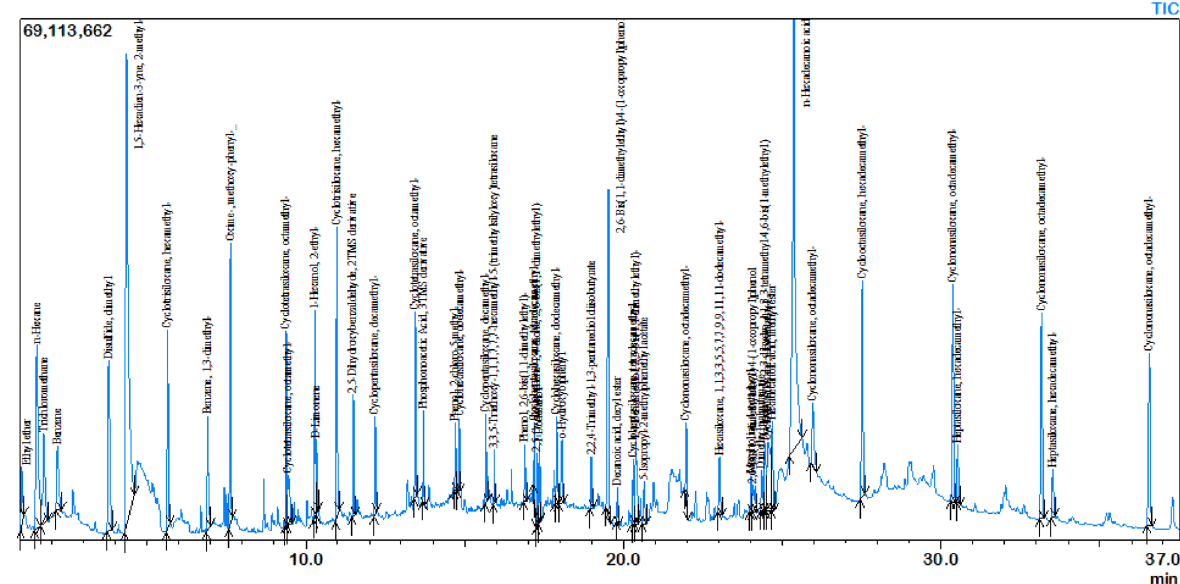
Figure 7. GC–MS chromatogram of volatile compounds produced by B. pseudomycoides.